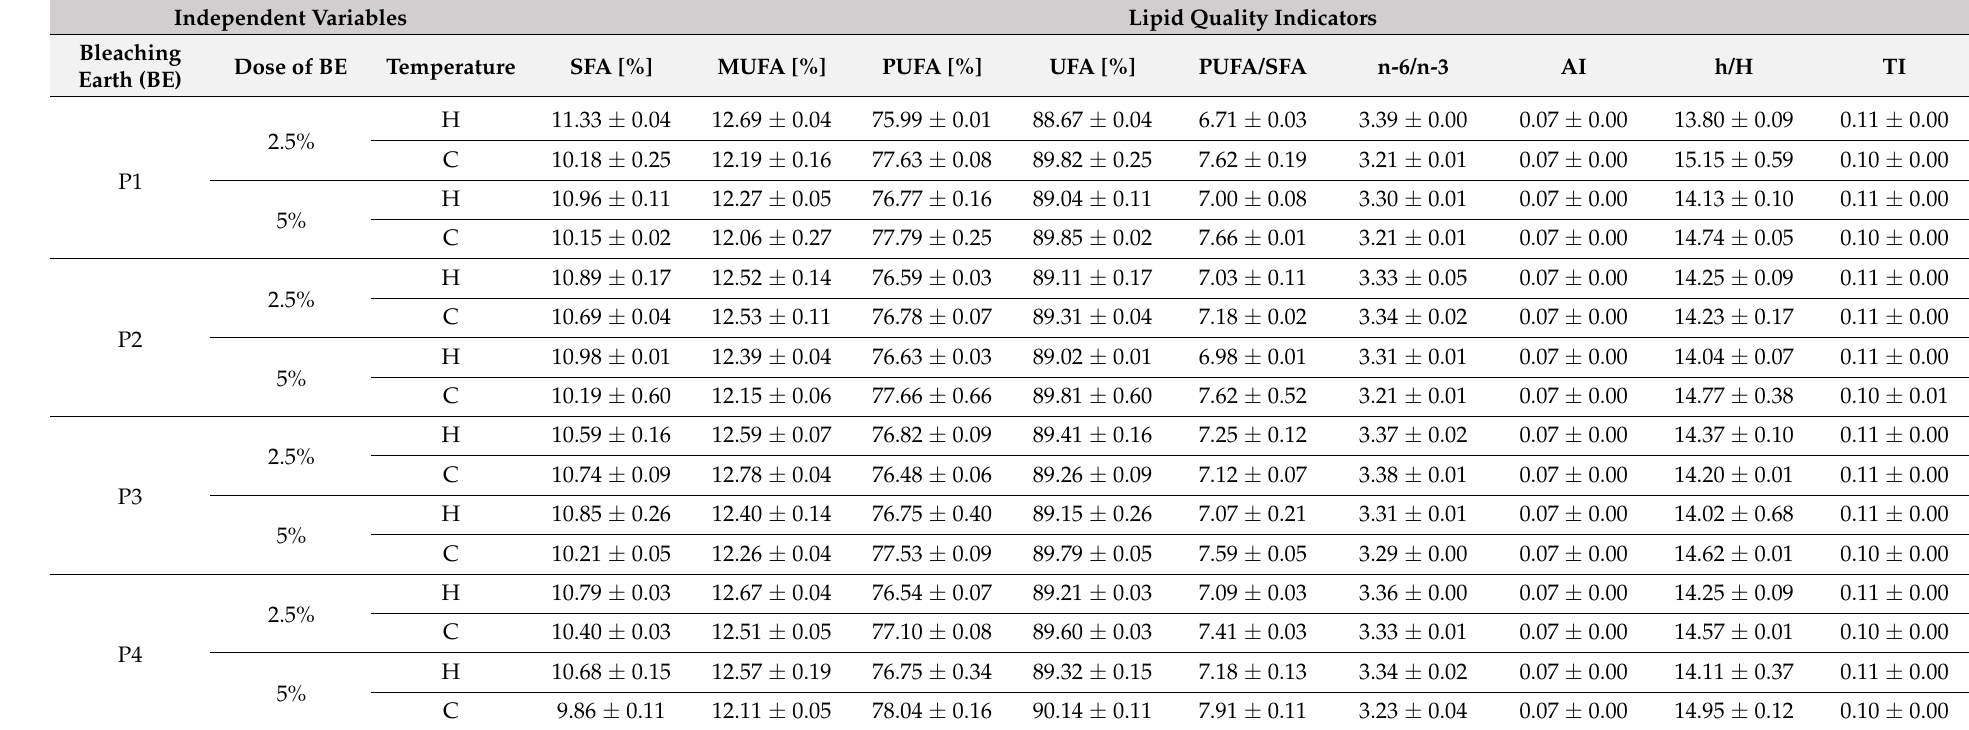
Table A2. Lipid quality indicators of bleaching hemp oil from the ‘S. Jubileu’